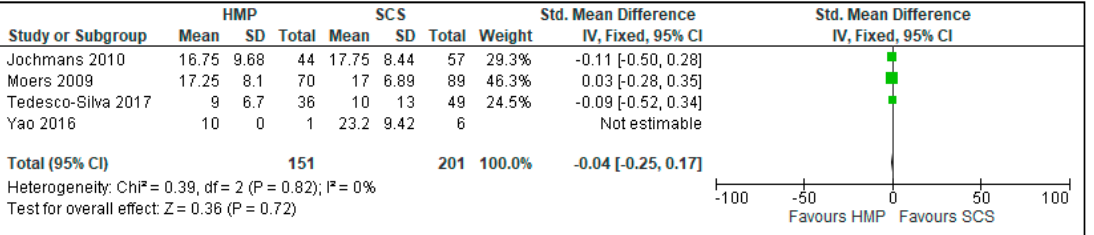
Figure 4. DGF duration in kidneys preserved by HMP and SCS. DGF duration was measured in days. In papers marked with “ * ”, mean and standard deviation were calculated using the method described